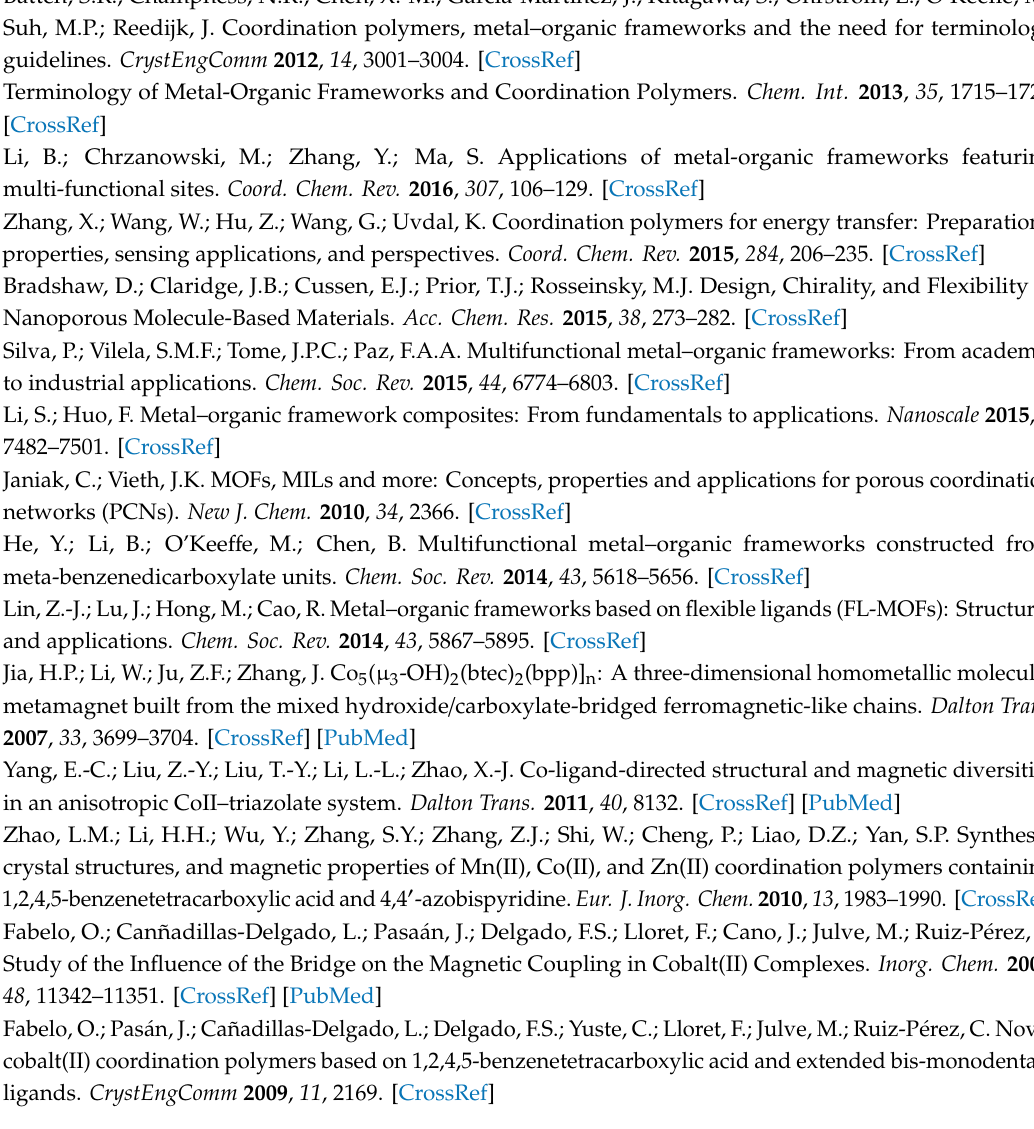
Figure S1: ( a ) TG measurement of 1 , ( b ) PXRD patterns at RT and selected temperatures and their simulation from single-crystal di ff raction data of 1 , Figure S2: ( a ) TG measurement of 2 , ( b ) PXRD patterns at RT and selected temperatures and their simulation from single-crystal di ff raction data of 2 , Table S1: Bond lengths (Å) and angles ( ◦ ) around Ni(II) ions in 1 , Table S2: Related parameters of hydrogen bonds in 1 , Table S3: Bond lengths (Å) and angles ( ◦ ) around Zn(II) ion in 2 , Table S4: Related parameters of hydrogen bonds in 2